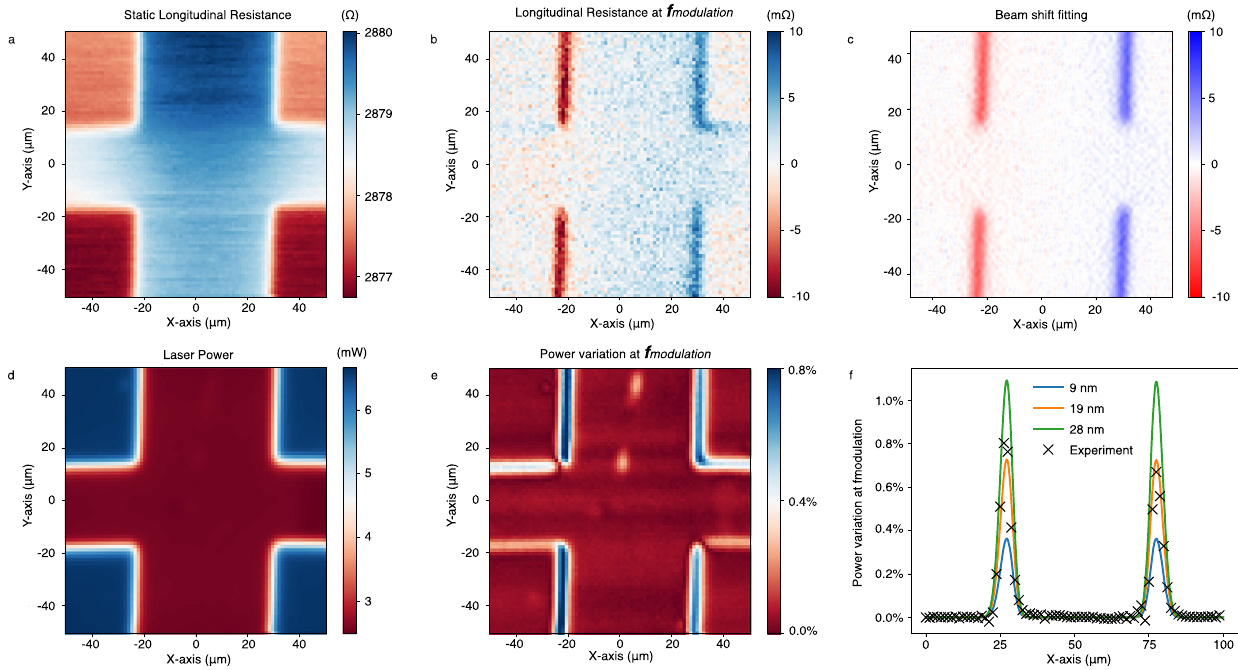
Fig. 3 | Beam shift estimation with beam shift induced resistance and power variation. a Static component of the longitudinal resistance mapping indicating the pro fi le of the cross. When illuminating the device, the longitudinal resistance increases. b Longitudinal photoresistance measured at the laser modulation fre- quency f modulation . c Fitting result obtained by subtracting the line-scan resistance fromashifted(by19nm)versionofitself. d Mappingofthestaticcomponentofthe